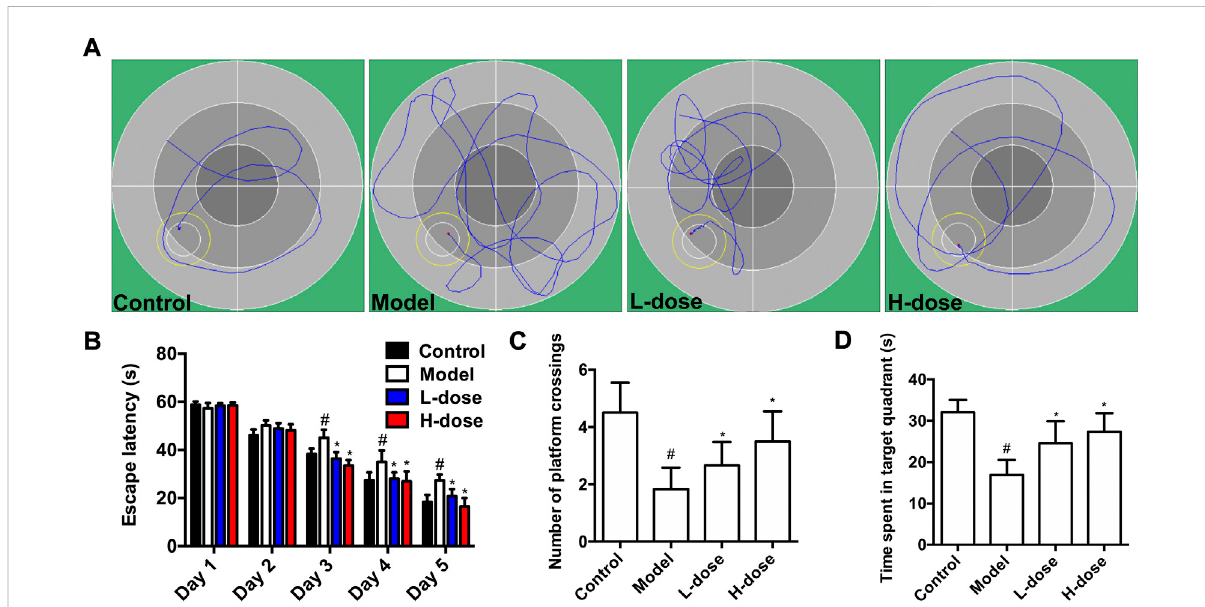
FIGURE 1 BLWE improved learning and memory ability in APP/PS1 mice. Representative individual swimming trajectory diagram in the water maze trial of each group (at day 5) (A) . Comparison of escape latency in different groups of mice in place navigation test (B) . Comparison of the number of platformcrossingsineachgroupinthespaceexplorationexperiment (C) .Comparisonofthetimespentintargetquadrantofeachgroupinthespace exploration experiment (D) . # p < 0.05 vs. the control group; * p < 0.05 vs. the model group. Values were expressed as the mean ± SD ( n = 6 per